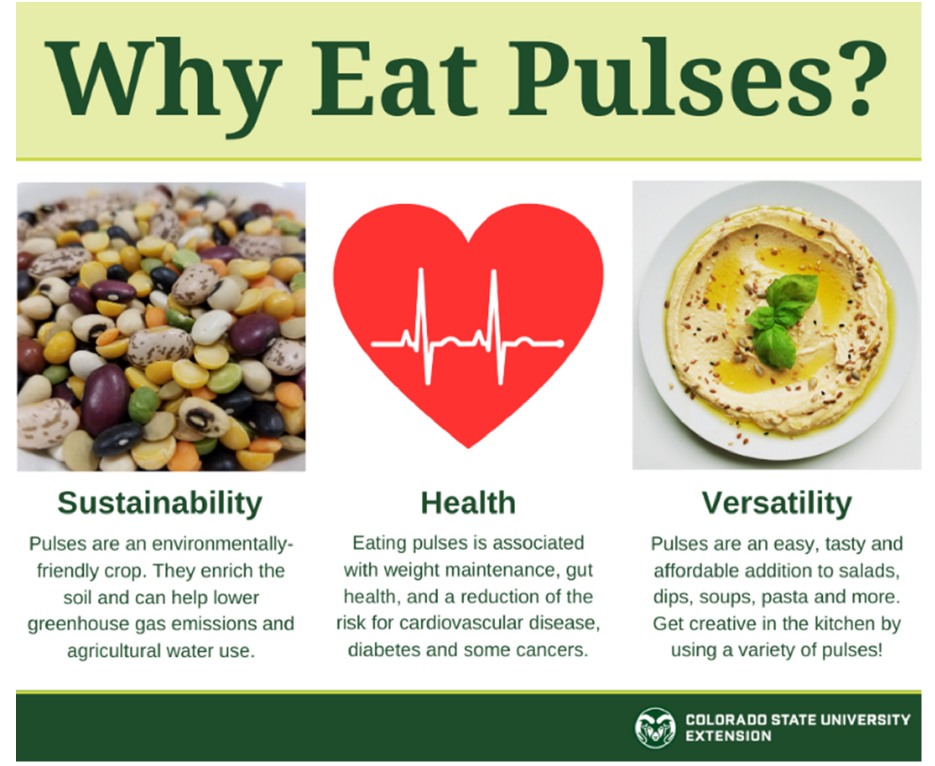
Figure 2. An example of pulse-centered outreach through Extension’s social media network, promoting three important aspects of pulses: sustainability, health, and versatility.